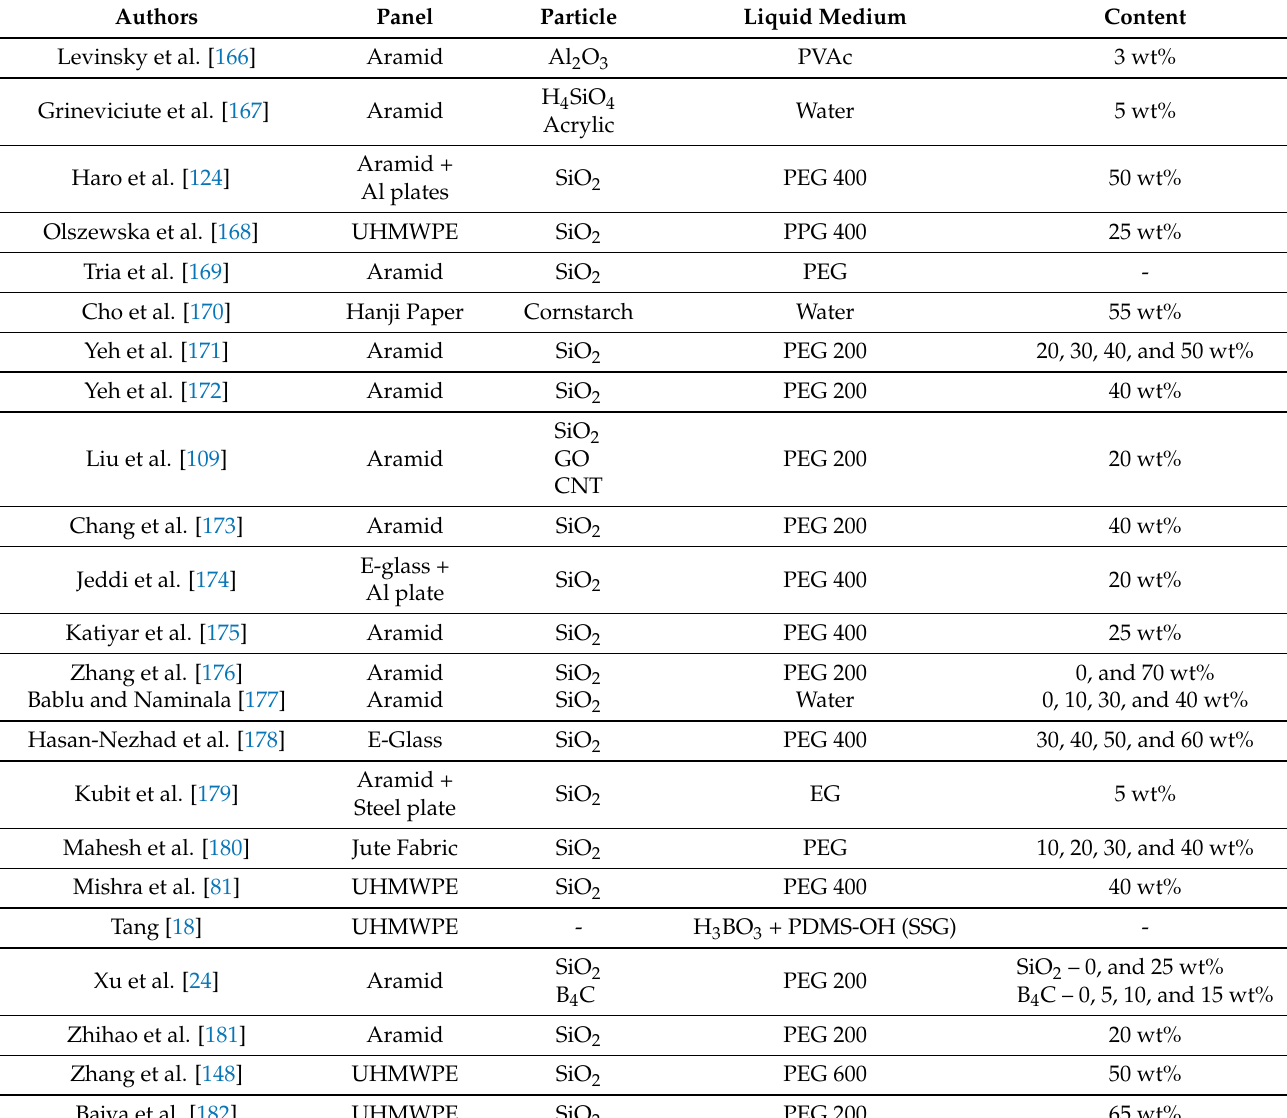
Table 6. Summary of materials used in unexplored publications related to shear thickening fluid and ballistic